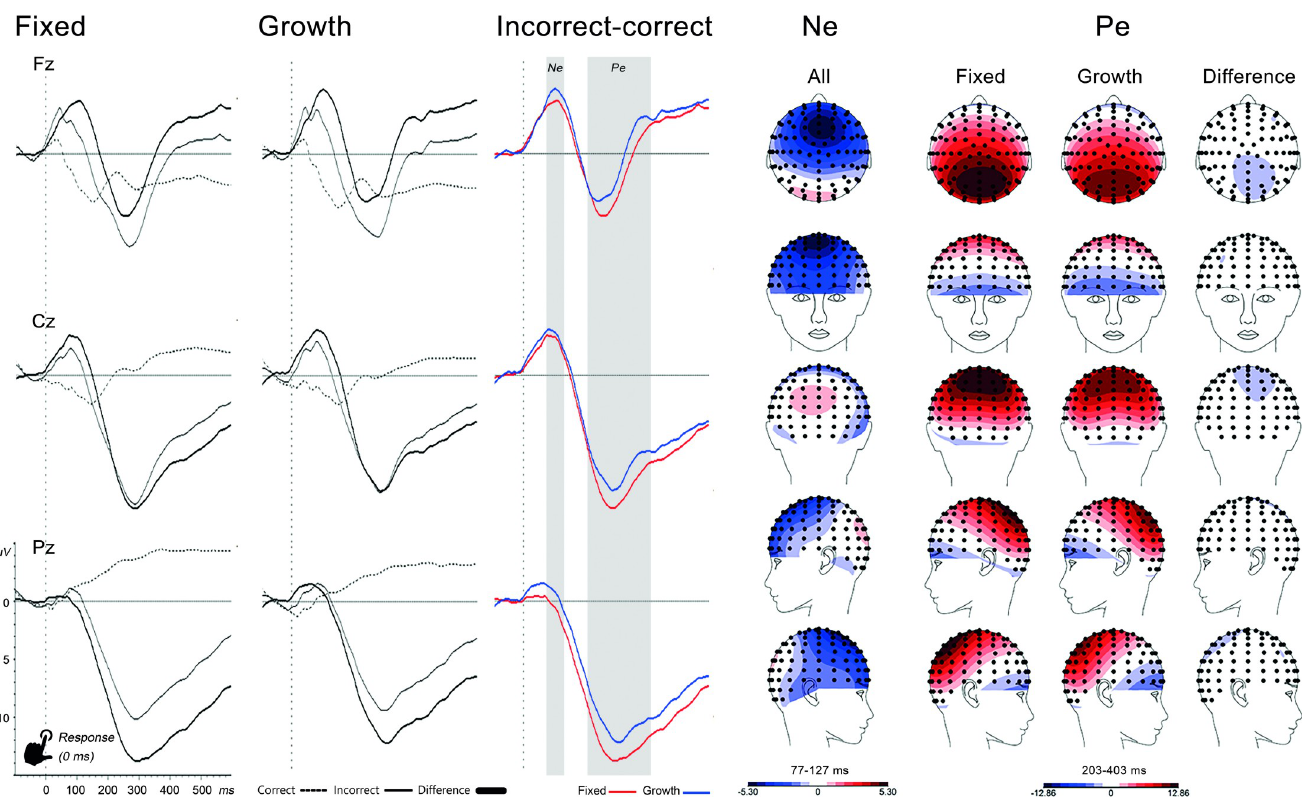
Fig 3. Response-locked ERPs for correct, incorrect (stop errors) and difference ERPs at midline electrodes with topographic maps of the difference wave Ne and Pe components. Note . For display purposes, a median split was used to show fixed and mindset difference-ERPs and Pe topographic maps. Gray areas are the Ne and Pe analysis